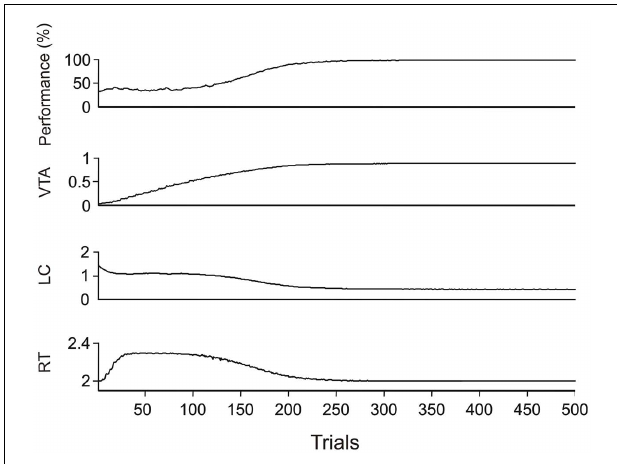
FIGURE 4 |Average values of performance in DMTS acquisition, activation levels ofVTA–SNc and LC and reaction times from 394 from 500 (78%) DMTS experiments where the performance reached 100%.